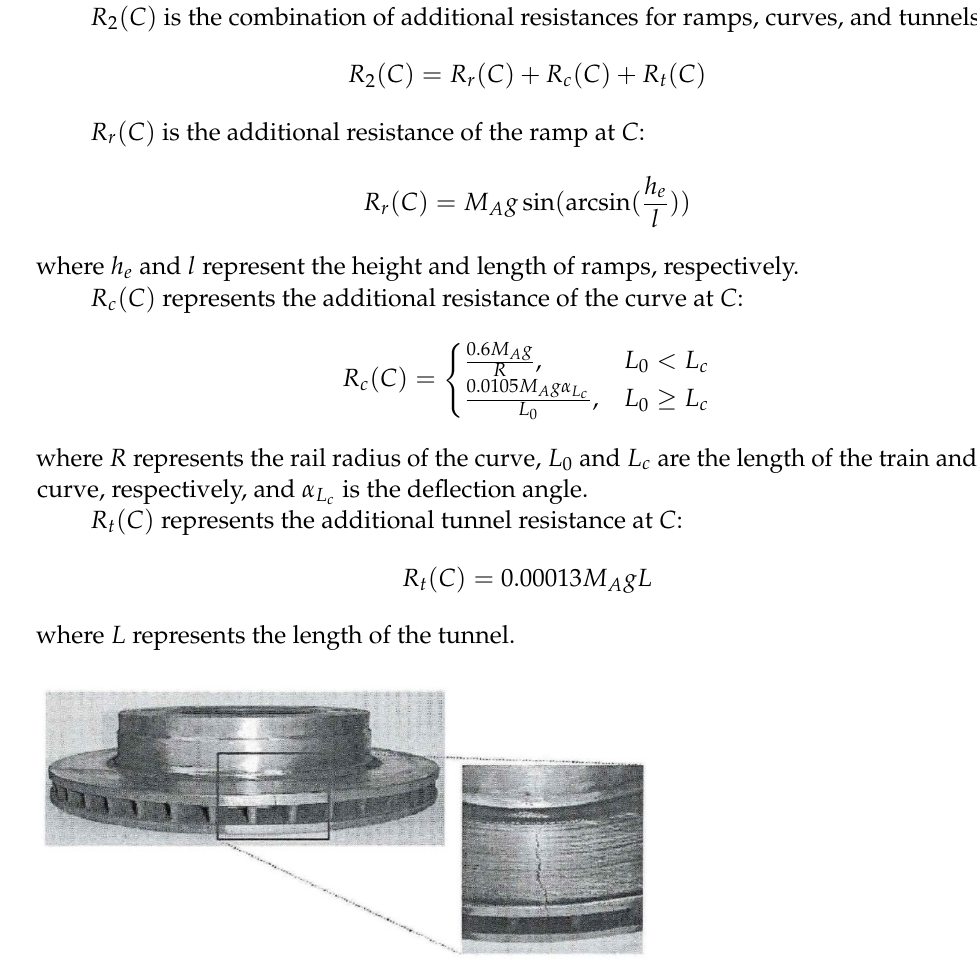
Figure 2. Severe wear and cracks of brake disc after long-term use.